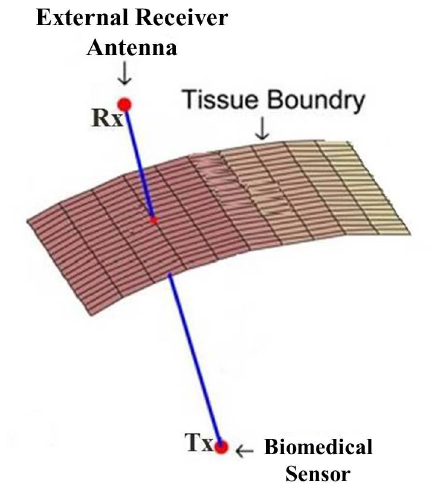
Figure 4. Signal transmission through tissue layers inside the human body; Tx: transmitter and Rx: